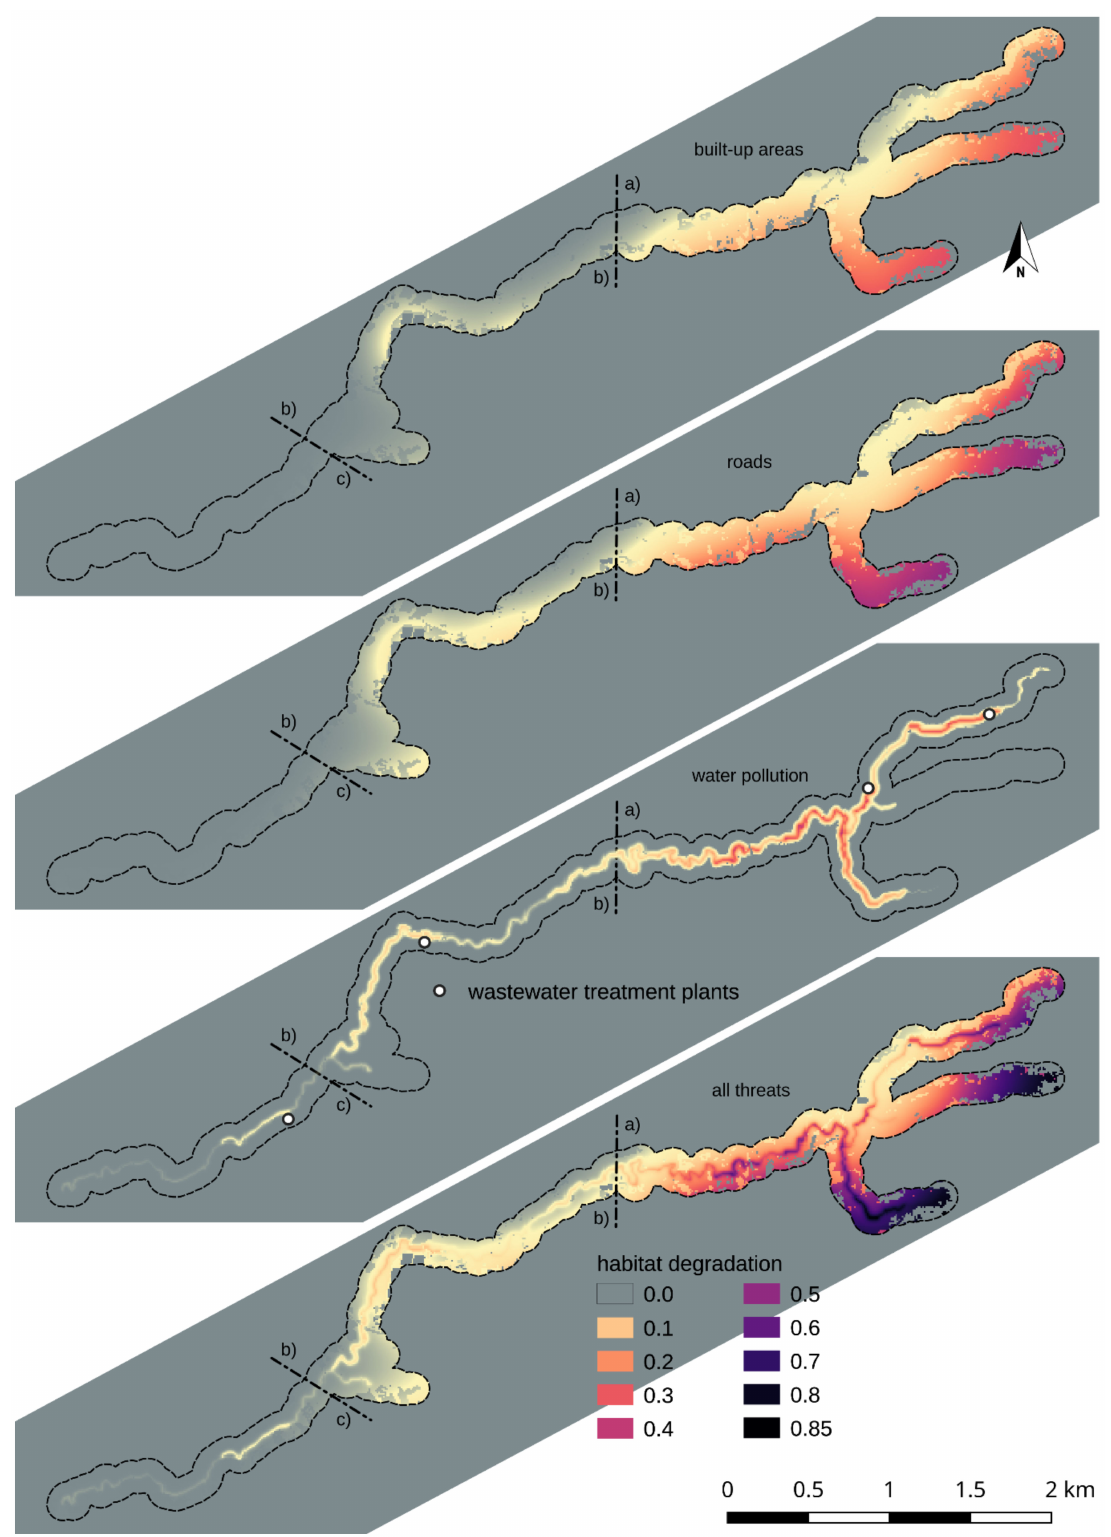
Figure 6. Habitat degradation due to all individual threats and the combination of these, divided into sections with very high ( a ), moderate ( b ), and very low habitat degradation levels ( c ). The grey shade is used as a background is used to provide a better